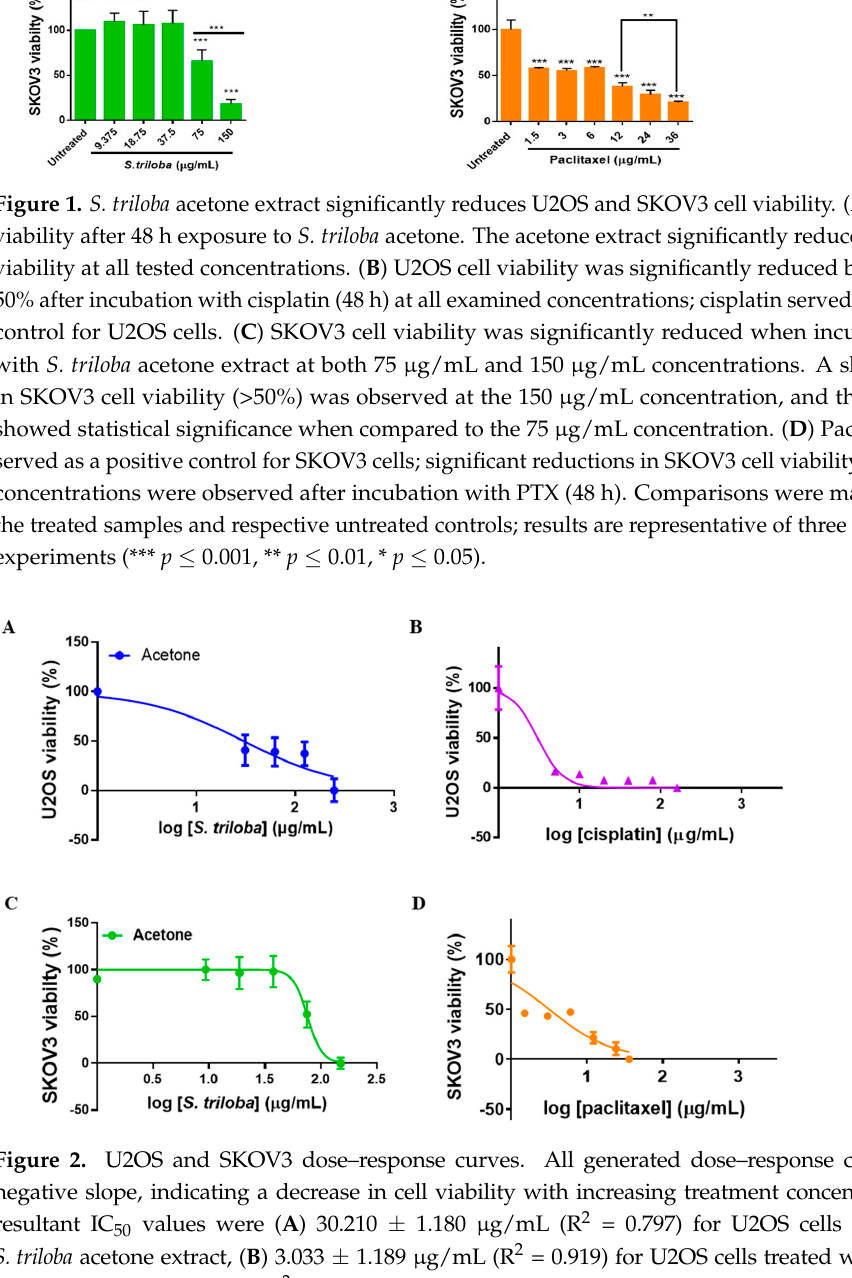
Figure 2. U2OS and SKOV3 dose–response curves. All generated dose–response curves had a negative slope, indicating a decrease in cell viability with increasing treatment concentration. The resultant IC 50 values were ( A ) 30.210 ± 1.180 µg/mL (R 2 = 0.797) for U2OS cells treated with S. triloba acetone extract, ( B ) 3.033 ± 1.189 µg/mL (R 2 = 0.919) for U2OS cells treated with cisplatin, ( C ) 75.960 ± 1.0237 µg/mL (R 2 = 0.890) for SKOV3 cells treated with S. triloba acetone extract, and ( D ) 3.148 ± 1.197 µg/mL (R 2 = 0.771) for SKOV3 cells treated with paclitaxel. Cisplatin and paclitaxel respec- tively served as positive controls for U2OS and SKOV3 cells; results are representative of three in- dependent experiments.